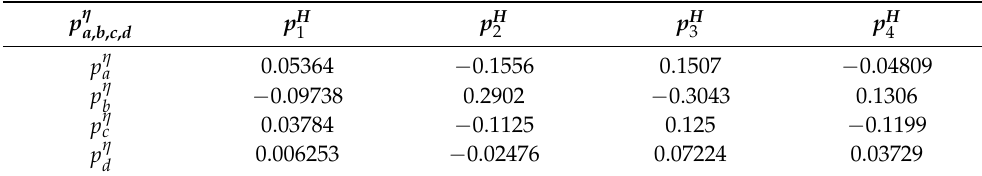
Table A3. Coefficients of the fitting model for Galileo system (Mean orbital height: 23,220 km).